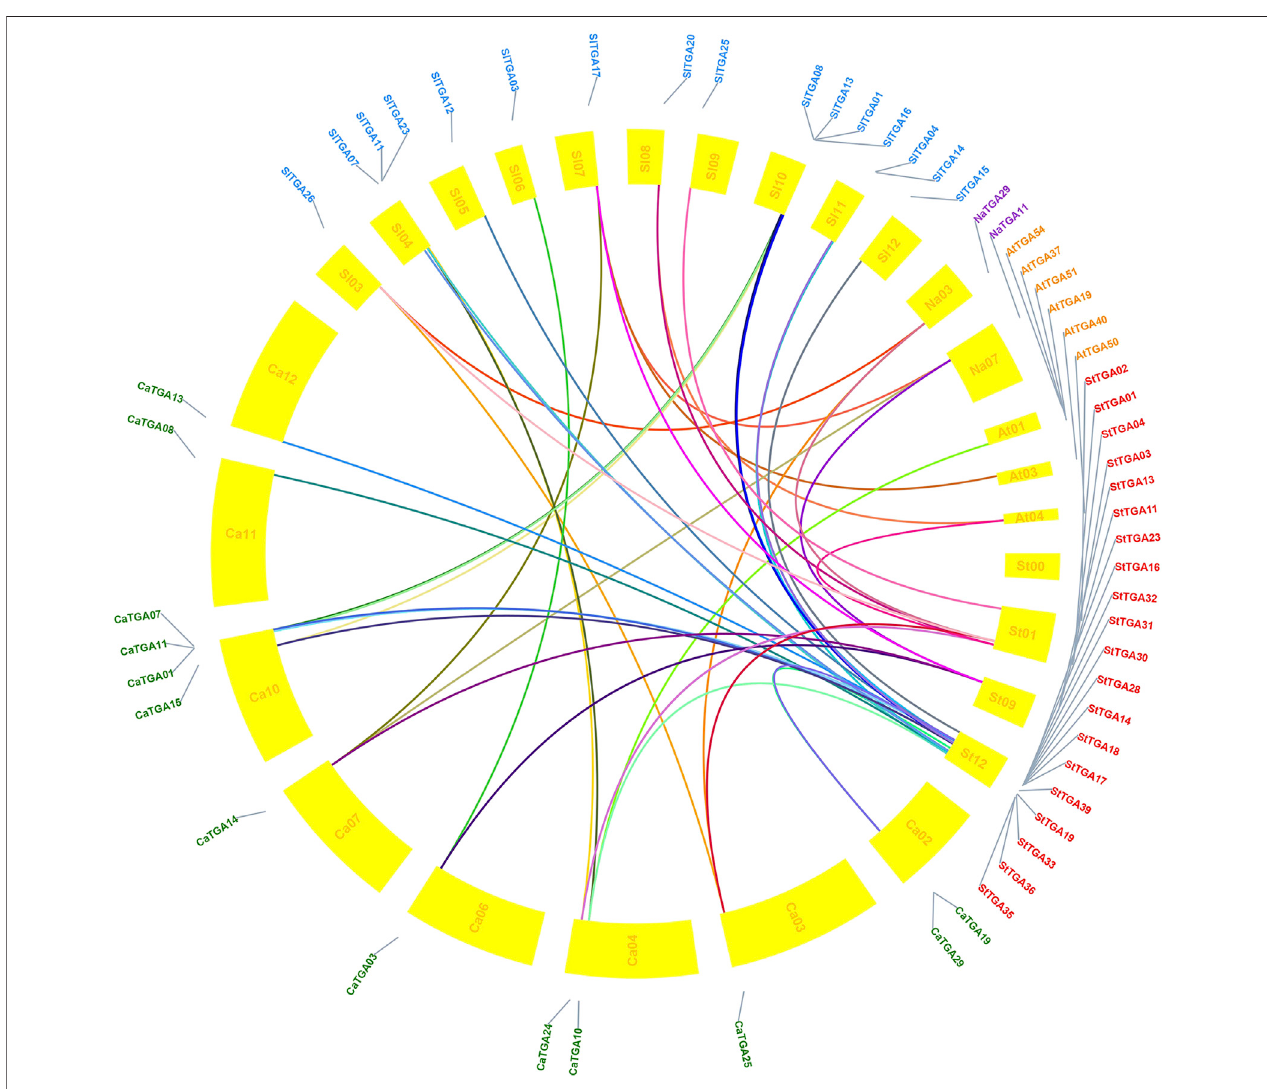
FIGURE 3 | Comparative orthologous relationships of TGA from fi ve species. TBtools was used to analyze the gene homology relationship between potato, tomato, pepper, Arabidopsis, and tobacco TGA gene families and visualize the gene homology relationship. TGA genes connecting fi ve species genome are shown in colored